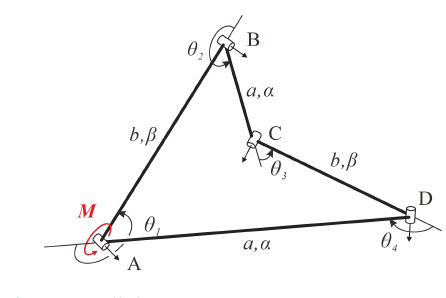
Figure 9. Bennett linkage.